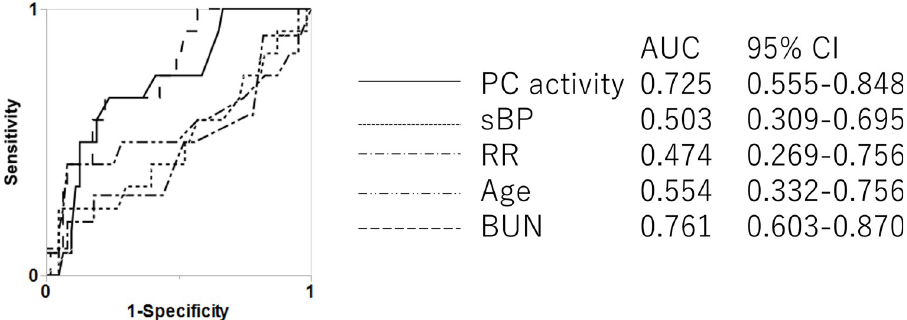
Fig 3. Evaluation of PC activity and each continuous variable of CURB-65 as predictors for in-hospital death of NHAP. PC = protein C; sBP = systolic blood pressure; RR = respiratory rate; BUN = blood urea nitrogen. � p < 0.05, comparing AUCs. The ROC curves of PC activity or each item of CURB-65 in NHAP are shown. The AUC of PC activity is second highest after BUN. Significant differences are apparent between the AUC of BUN and that of systolic blood pressure (p = 0.035). There was no significant difference between the AUC of PC activity and those of the CURB-65 items.